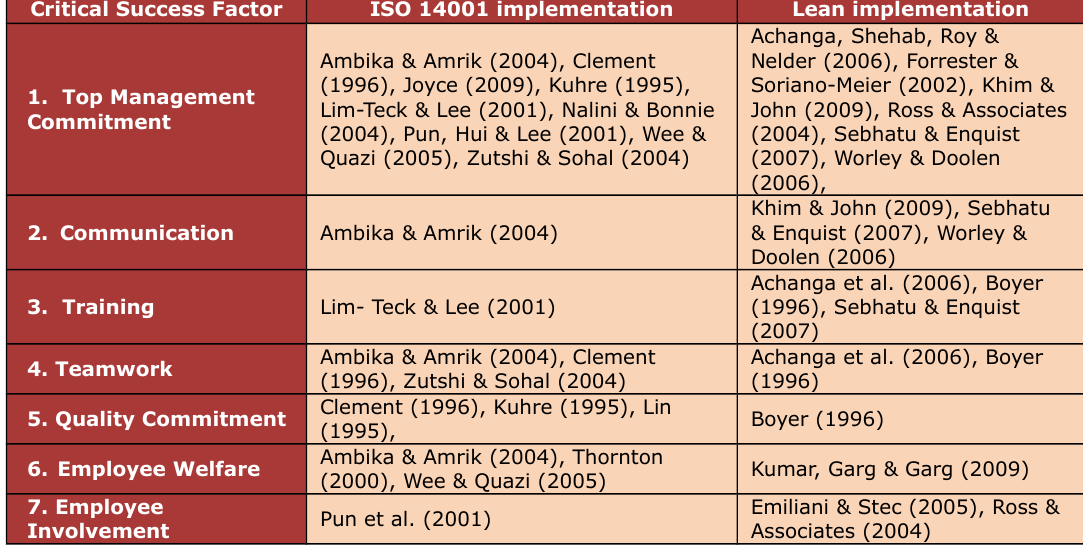
Table 6. Critical Success Factors for Lean and ISO 14001